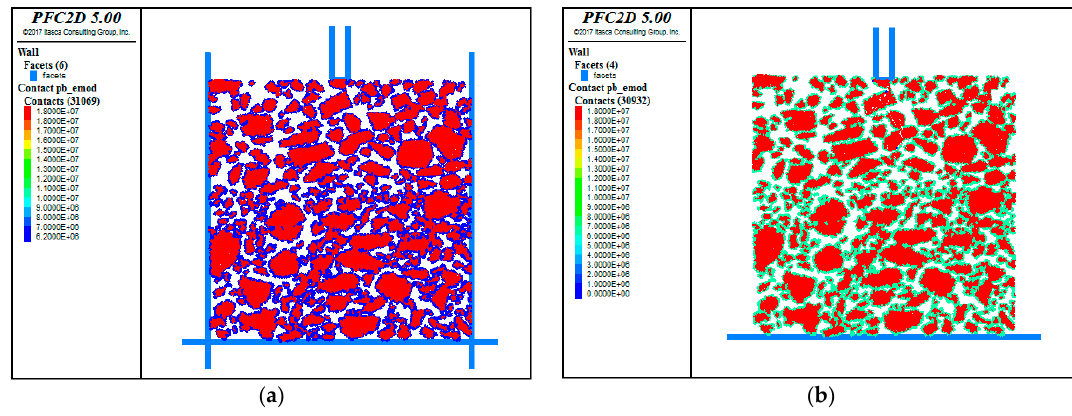
Figure 16. Comparison of the effective cohesive modulus of the specimens before and after the test. ( a ) Before the test; ( b ) After the test.